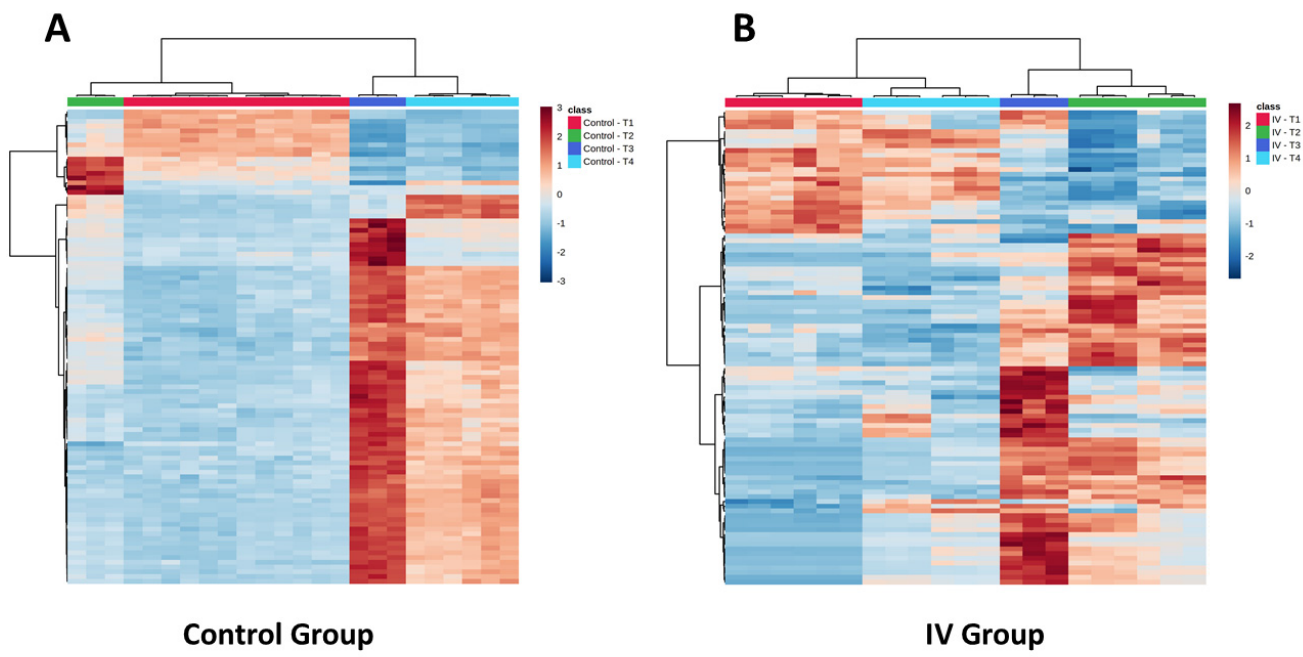
Figure 3. Heatmaps representing control and IV groups (positive ESI) for the top 100 discriminating features. The four time points (each urine pool in triplicate) are represented as pre-dose (T1, red) and 0–3 h (T2, green), 3–8 h (T3, dark blue), and 8–24 h (T4, light blue) post-dose. Euclidean distance and Ward clustering were applied in both cases. In the case of the control group ( A ), no urine was obtained for one of the groups at T2 and T3. Similarly, for the IV group ( B ), no sample was obtained for one group at time T3. For comparison, the pre-dose vs. post-dose urine from both the control and dosed groups are shown in ( A ) to illustrate the similarity in profiles of all animals prior to study